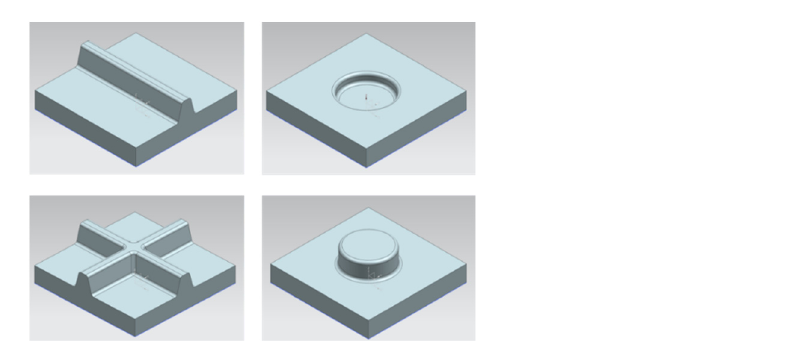
Figure 16. Targeted designs of mockup molds to tackle the challenges in various complexity levels.